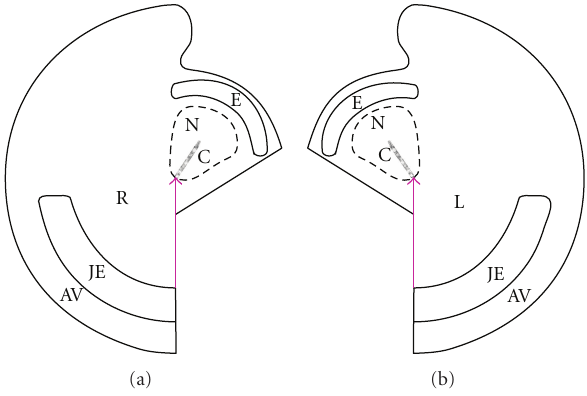
Figure 7: (a): Schematic representation of the di ff erent structures found in a right hemi-embryo after 1 day of culture. The head region is bent over the original midline and contains the endophyllic crescent (E) with associated primordial germ cells. A central noto- chord (C) and prechordal plate have formed below a symmetrical neural plate (N). A hemi-primitive streak (indicated by a red half arrow) is localized in the cut edge of the hemi-embryo. R, right side of the original blastoderm; JE, half junctional endoblast derived from the original half Rauber’s sickle with parallel area vasculosa (AV). (b): Schematic representation of the structures found in a left hemi-embryo after 1 day of culture; the same indications as in Figure 7(a) but at the left side